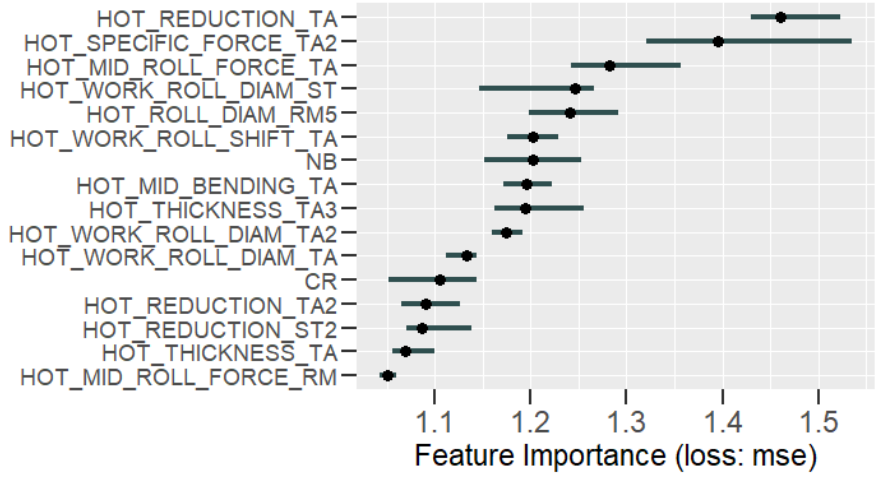
Figure 4. Variable importance for Model_HOT.